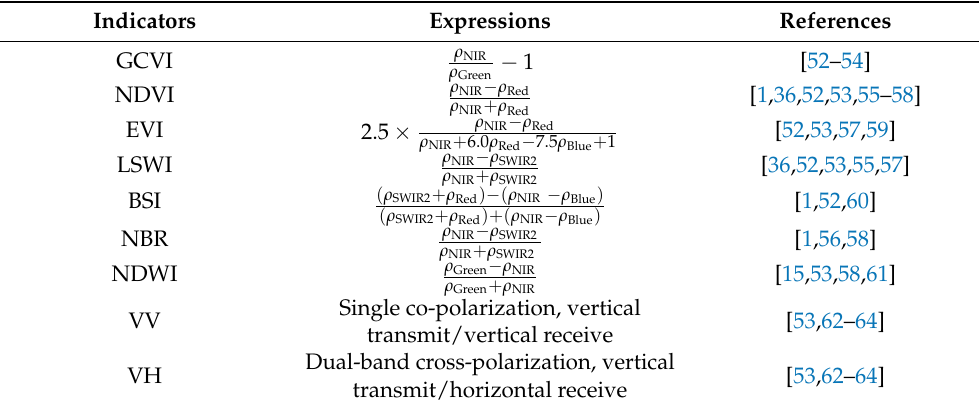
Table 2. Spectral indices and their expressions from Sentinel-1 and Sentinel-2.